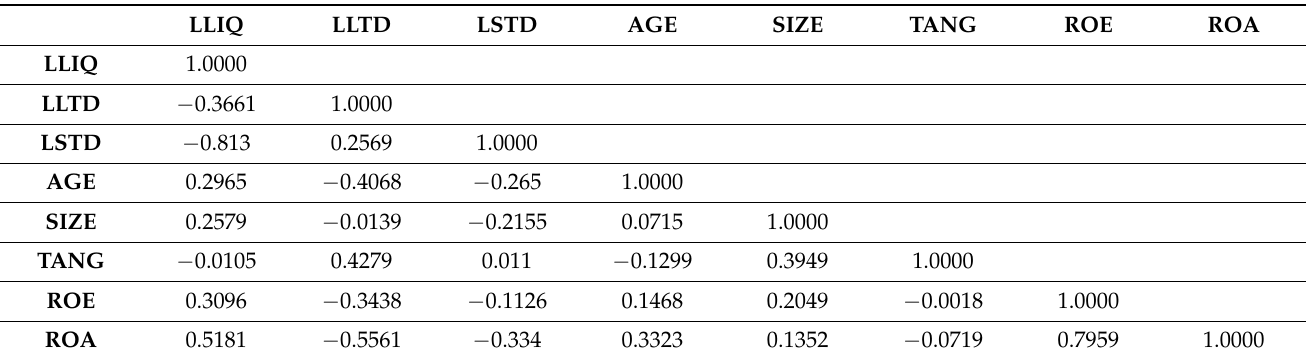
Table 2. Correlation Matrix.